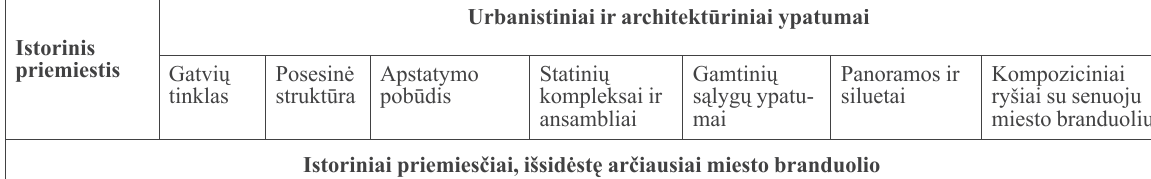
Table 2. Urban and architectural peculiarities of historic suburbs of Vilnius (preserved